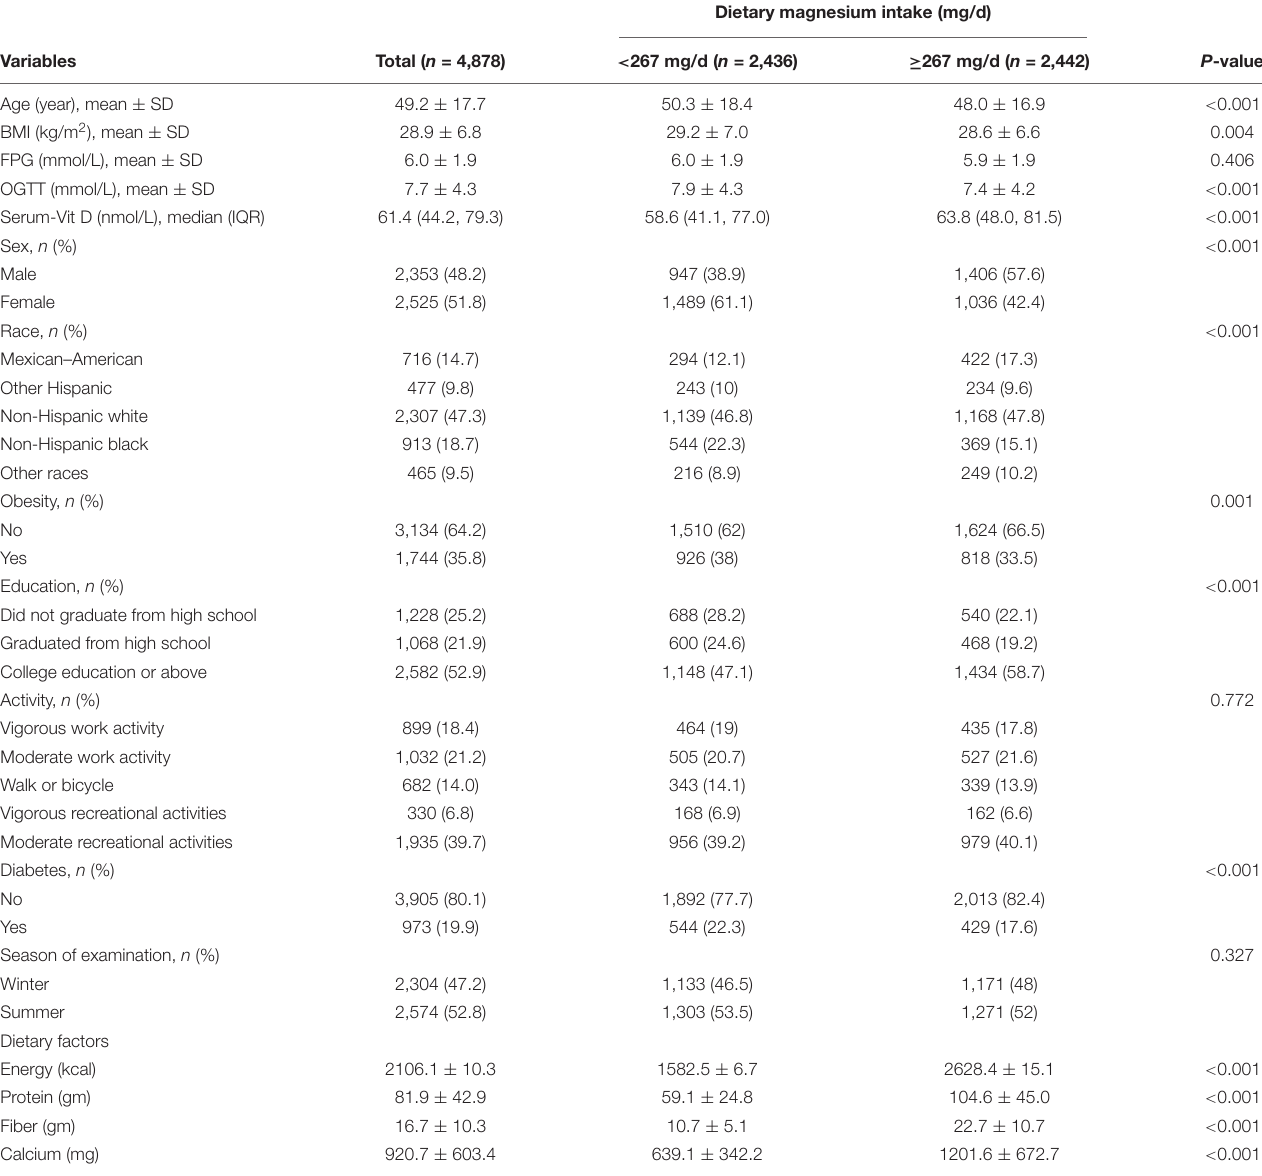
TABLE 1 | Basic information description of